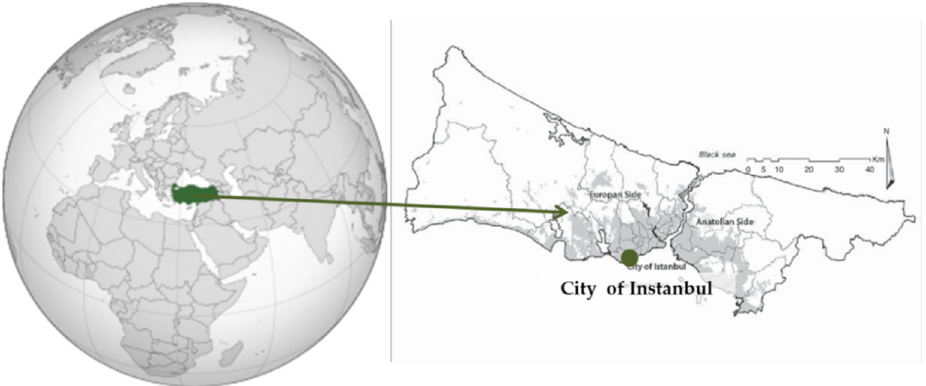
Figure 2. Study Figure 2. Study area.